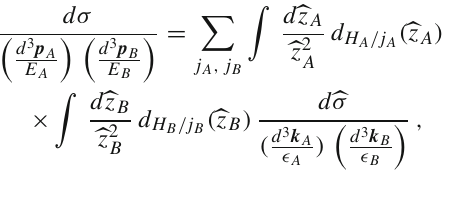
Fig. 1 a Pictorial representation of (the hadronic part of) a DIS pro- cess. The struk quark is associated to the collinear part relative to the target hadron, while the radiated gluon is the hard real emission. b Pic- torial representation of (the hadronic part of) e + e − → H X . The quark